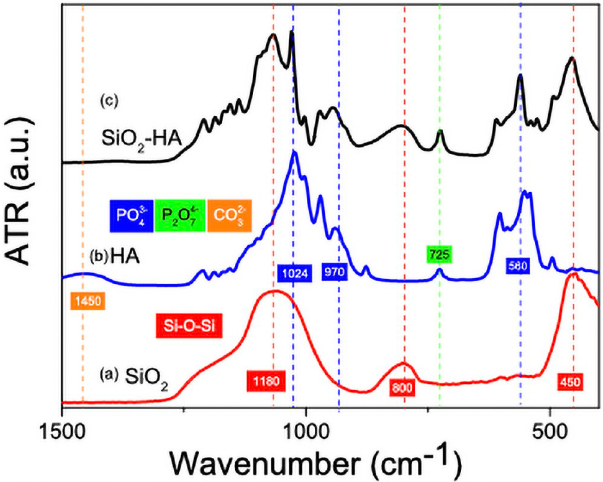
Fig 2. IR spectrums of a) SiO 2 fibers, b) HA fibers and c) SiO 2 -HA composite